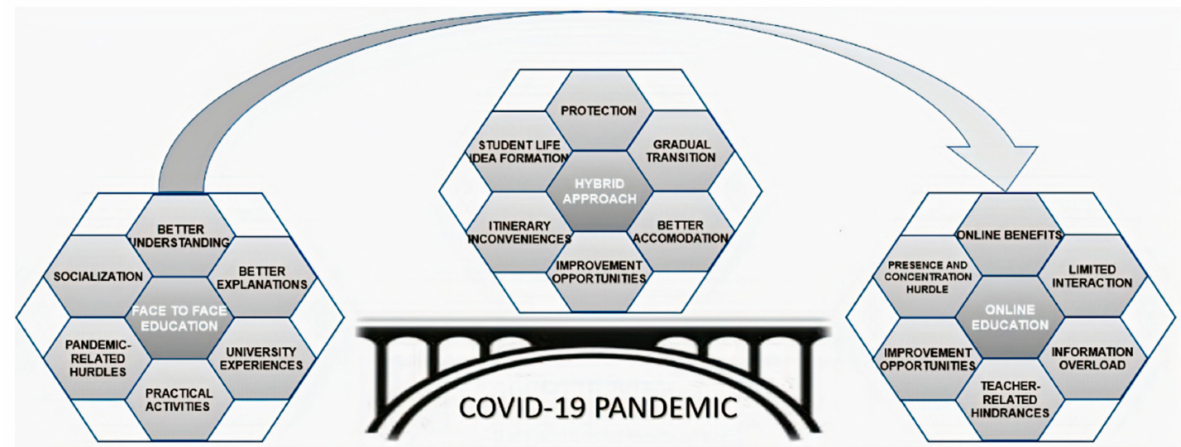
Figure 3. A theoretical model for the Romanian higher education system in the COVID-19 pandemic situation based on student